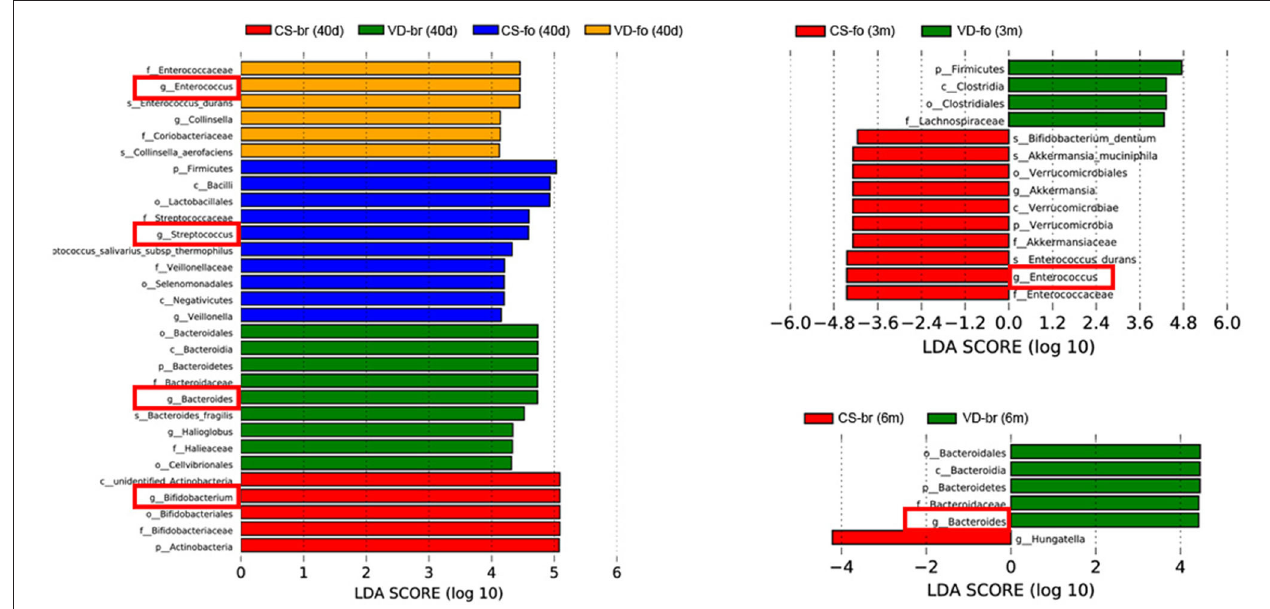
FIGURE 6 | LDA scores for the bacterial taxa differentially abundant among different groups (LDA > 4.0). Bars with different colors indicate taxa were enrichment in corresponding groups. Red squares mark the main different microbiota at genus